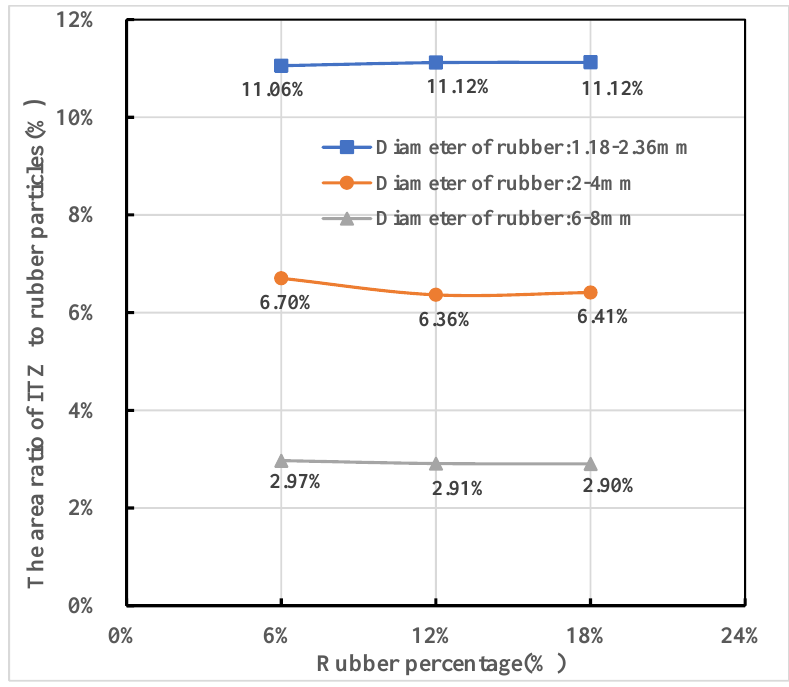
Figure 13. The area ratio of ITZ to rubber particle in CRM.